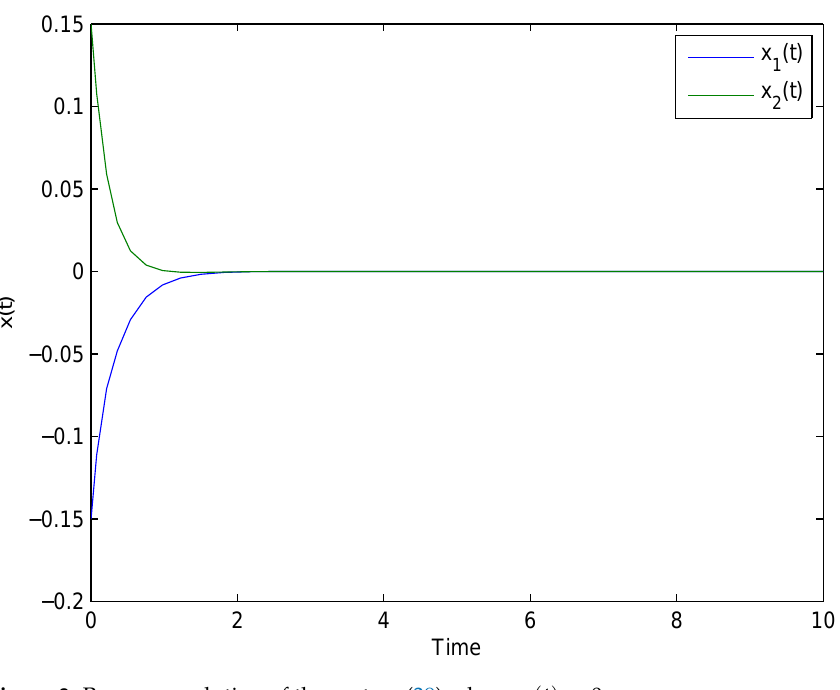
Figure 3. Response solution of the system (39) where w ( t ) =